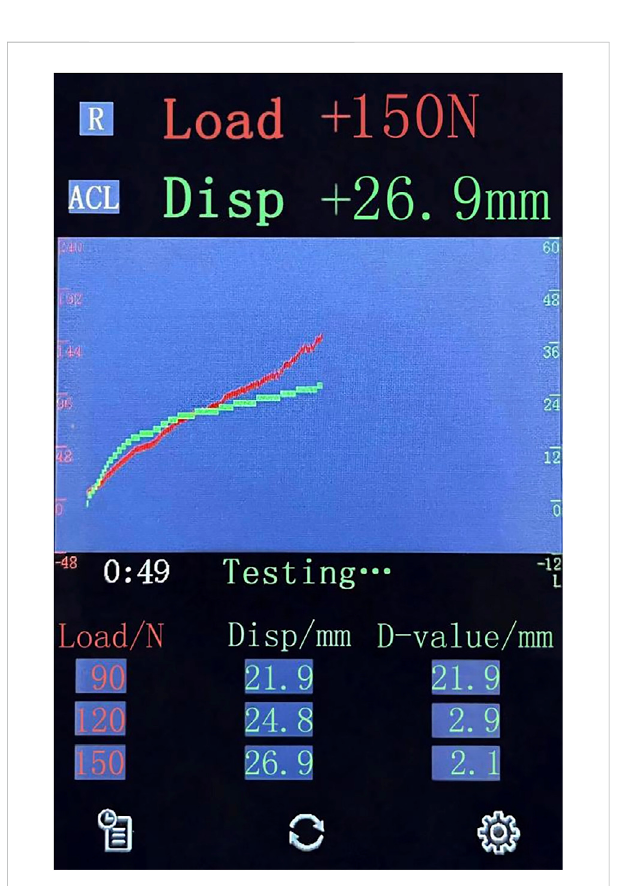
FIGURE 3 The display interface of the Ligs Digital Arthrometer for data collection. Load, the applied load; Disp, anterior displacement of the knee; D-value, the difference value of displacement between the current load and the prior